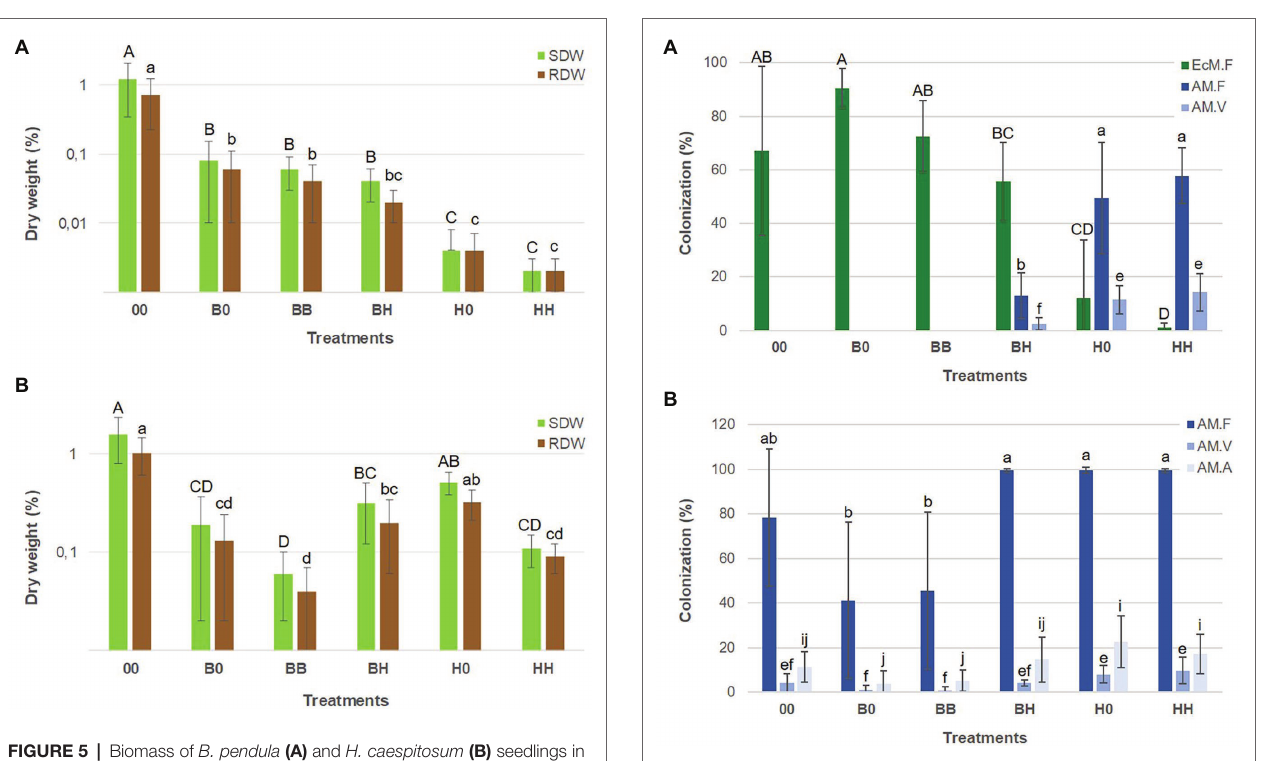
FIGURE 6 | Mycorrhizal colonization of B. pendula (A) and H. caespitosum (B) seedlings in each treatment. EcM.F = frequency of EcM colonization, AM.F = frequency of AM colonization, AM.V = abundance of vesicles, AM.A = abundance of arbuscules. For each variable, significant differences between treatments ( n = 8) are indicated with different letters (uppercase for EcM.F and lowercase for AM.F [a-b], AM.V [e-f] and AM.A [i-j]). Treatments: 00 = without plants in lateral compartments, B0 = B. pendula in only one lateral compartment, BB = B. pendula in both lateral compartments, BH = B. pendula and H. caespitosum in lateral compartments (interaction treatment), H0 = H. caespitosum in only one lateral compartment, HH = H. caespitosum in both lateral